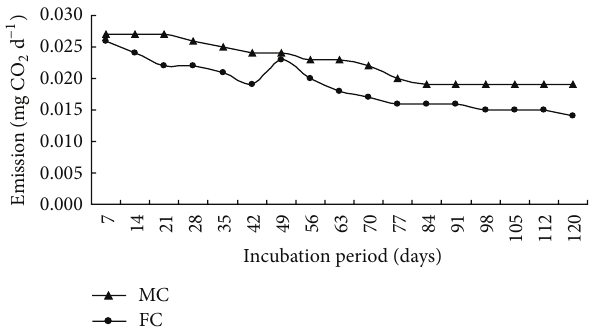
Figure 2: Rate of decomposition at different water